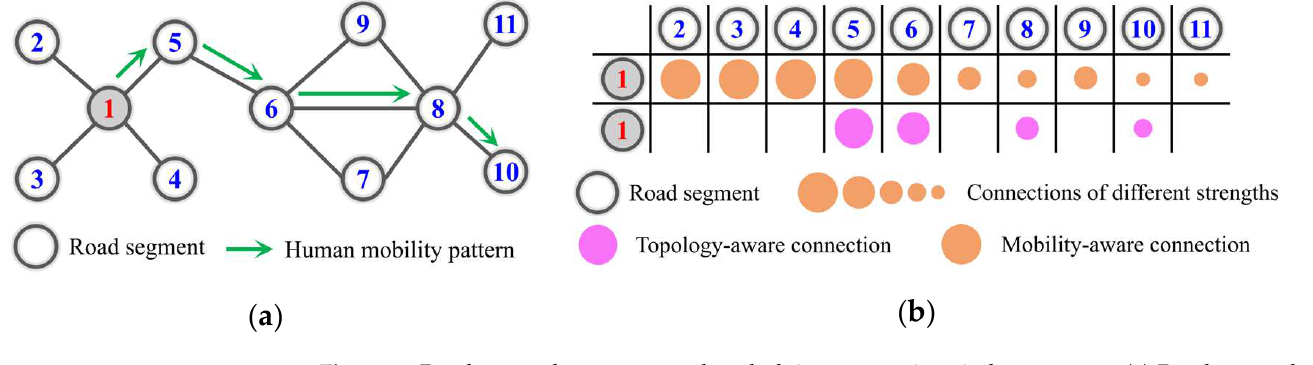
Figure 1. Road network structure and underlying connections in latent space. ( a ) Road network structure; ( b ) different connections in latent space.